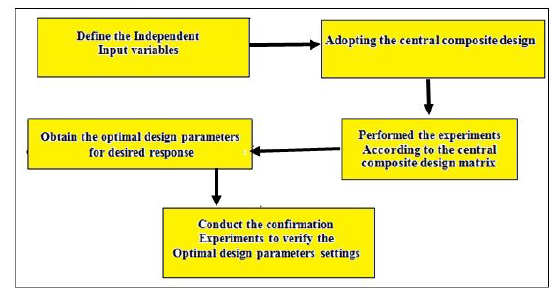
Figure 4: Steps Involved in Central Composite Design